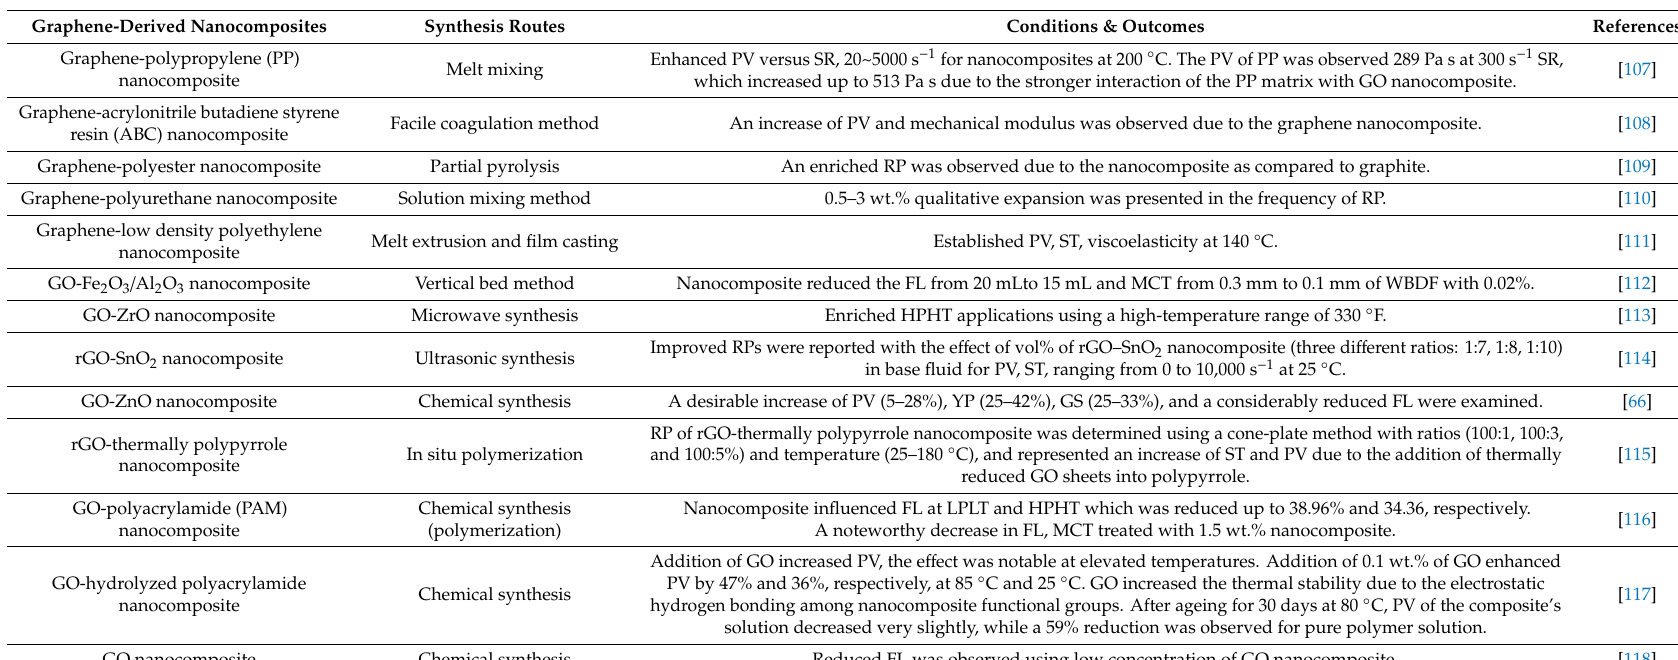
Table 2. Summary of the graphene nanocomposites in